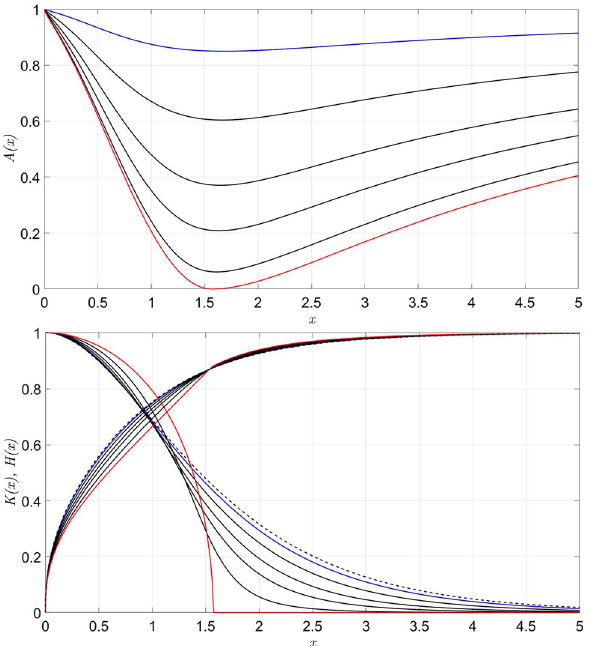
Fig. 1 Functions of A ( x ) , K ( x ) and H ( x ) versus x of the fundamen- tal gravitating electroweak monopole with physical β and Weinberg angle for α = 0 . 6 (blue), 1 . 0 , 1 . 3 , 1 . 5 , 1 . 7 and 1 . 814 (red). Dashed line indicates non-gravitating monopole